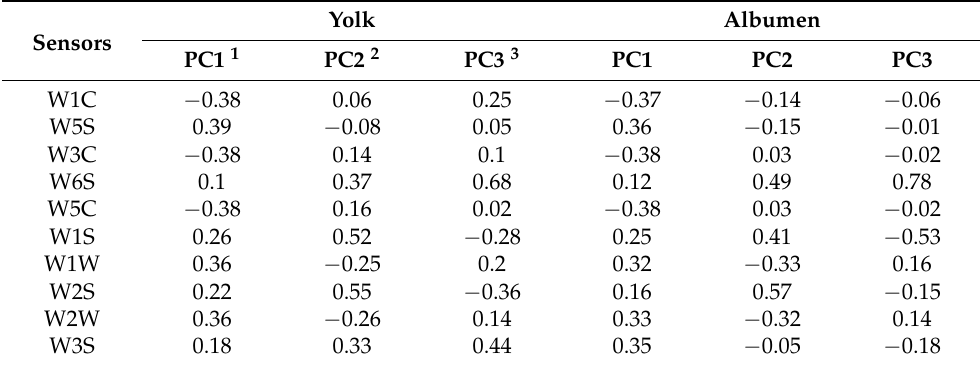
Table 5. Electronic nose-load coefficients of egg yolks and albumen by principal component analy- sis (PCA).